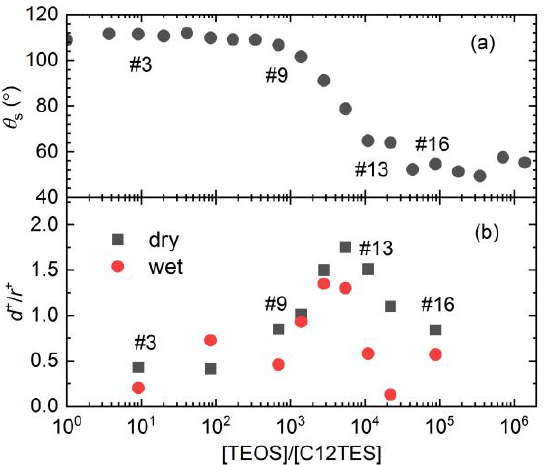
Figure 4. Changes in the ( a ) static water CAs and ( b ) s -CH 2 / s -CH 3 ratios of the hybrid films under dry and wet conditions as a function of the [TEOS]/[C12TES] molar ratios. [TEOS]/[C12TES] ratios = 9.1 (#3), 690 (#9), 11,000 (#13), 88,000 (#16).